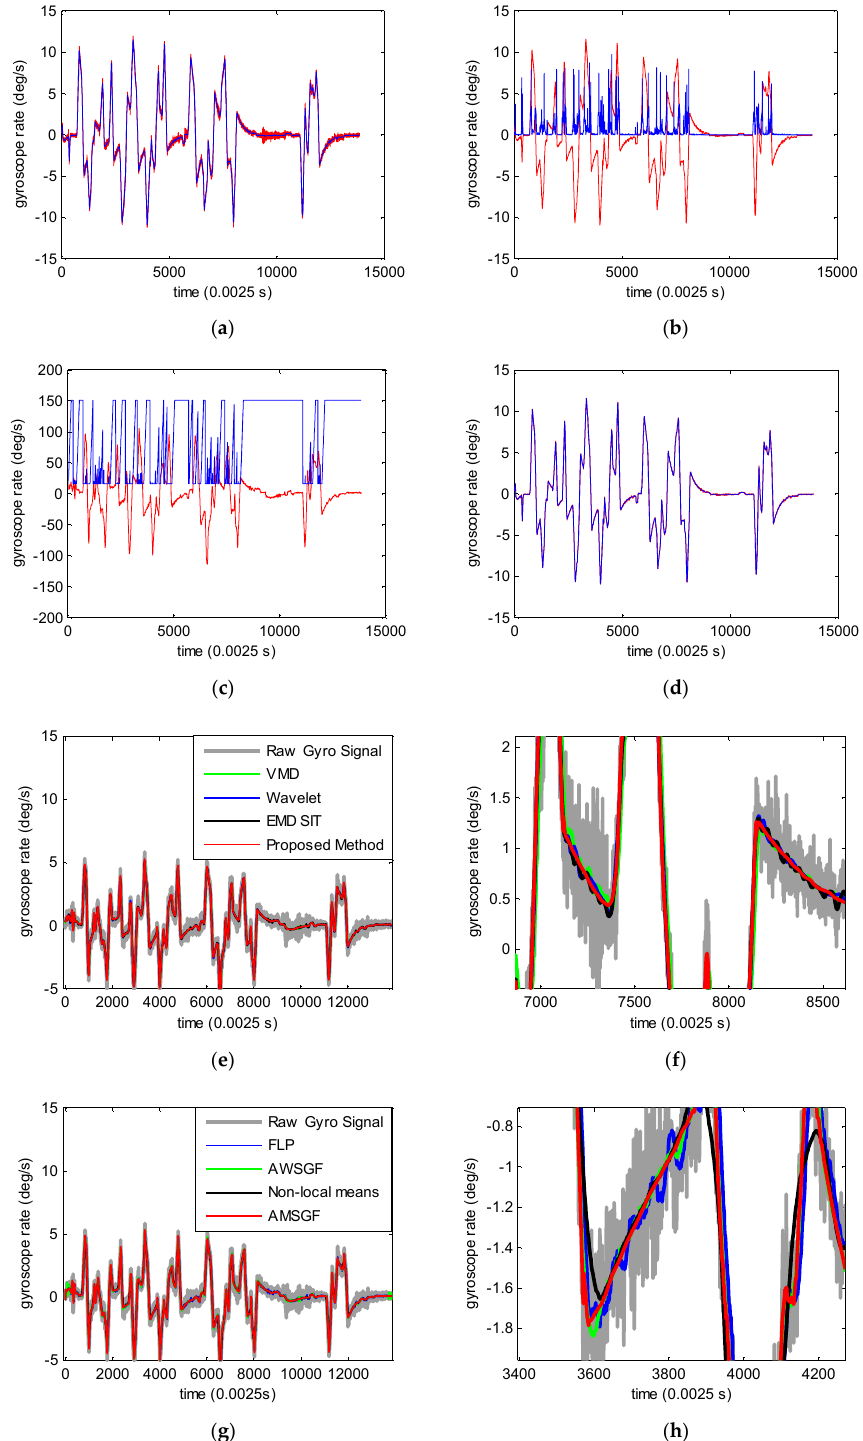
Figure 8. Arbitrary multiple-rate motion experiments. ( a ) ACMP results (red: original gyroscope signal; blue: ACMP results). ( b ) Sample variance (red: ACMP results. blue: 50,000 times magnified sample variance). ( c ) The window size for di ff erent samples, W max = 151, W min = 15, λ th = 2.5 × 10 − 6 , M = 3 for AMSGF (red: 10 times magnified ACMP results; blue: window size selection of AMSGF for di ff erent samples). ( d ) Final denoising results (red: ACMP results. blue: further denoising results using AMSGF). ( e ) Denoising results of di ff erent denoising methods. ( f ) Local magnified image of denoising results in ( e ). ( g ) Denoising results of di ff erent smoothing methods. ( h ) Local magnified image of denoising results in ( g